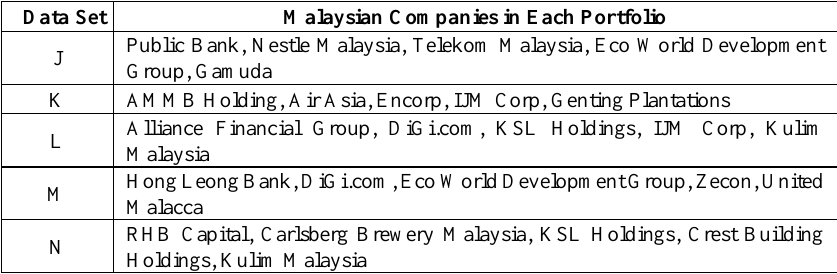
Table 1. Data sets J, K, L, M and